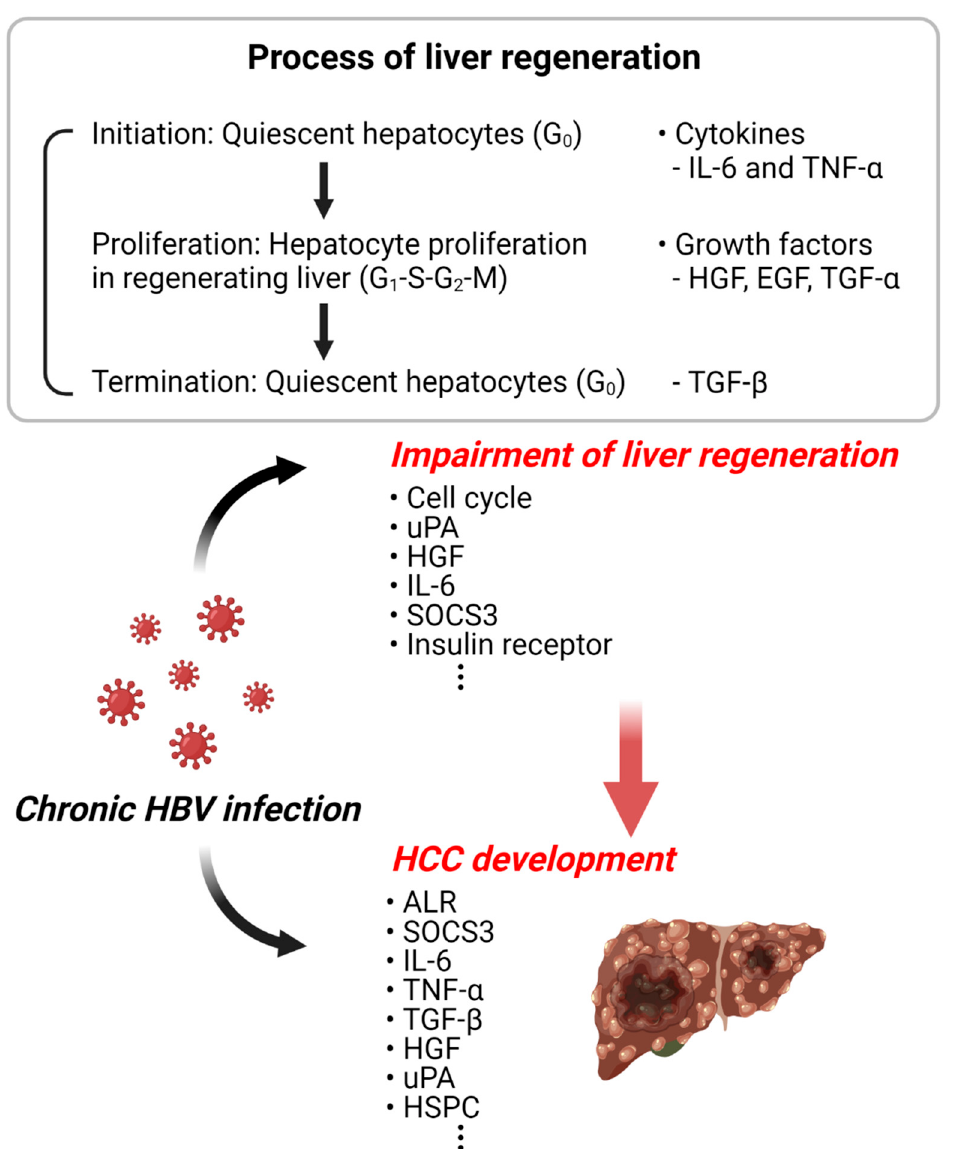
Figure 2. Schematic diagram of HBV-related liver regeneration and HCC. The illustration represents the increased incidence of liver cancer due to the abnormal liver regeneration caused by HBV infection. This illustration was created with BioRender.com (accessed on 18 June 2022).